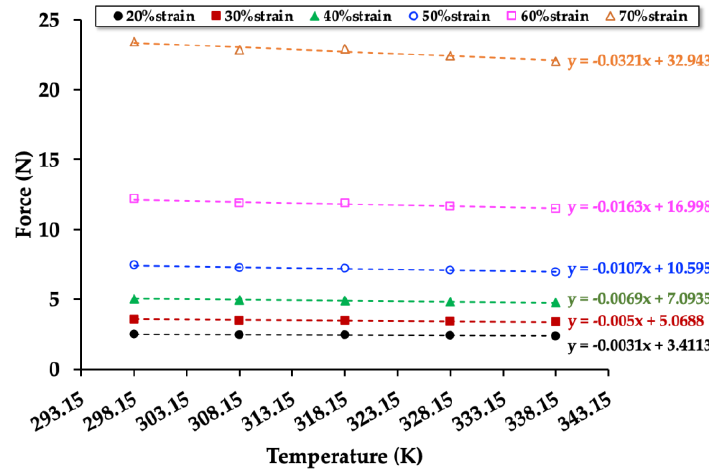
Figure 8. Force at a constant strain as a function of the temperature of the NRF with 8 phr of charcoal (NRF / 8 Ch) with a minimum of R 2 = 0.9 in each strain.